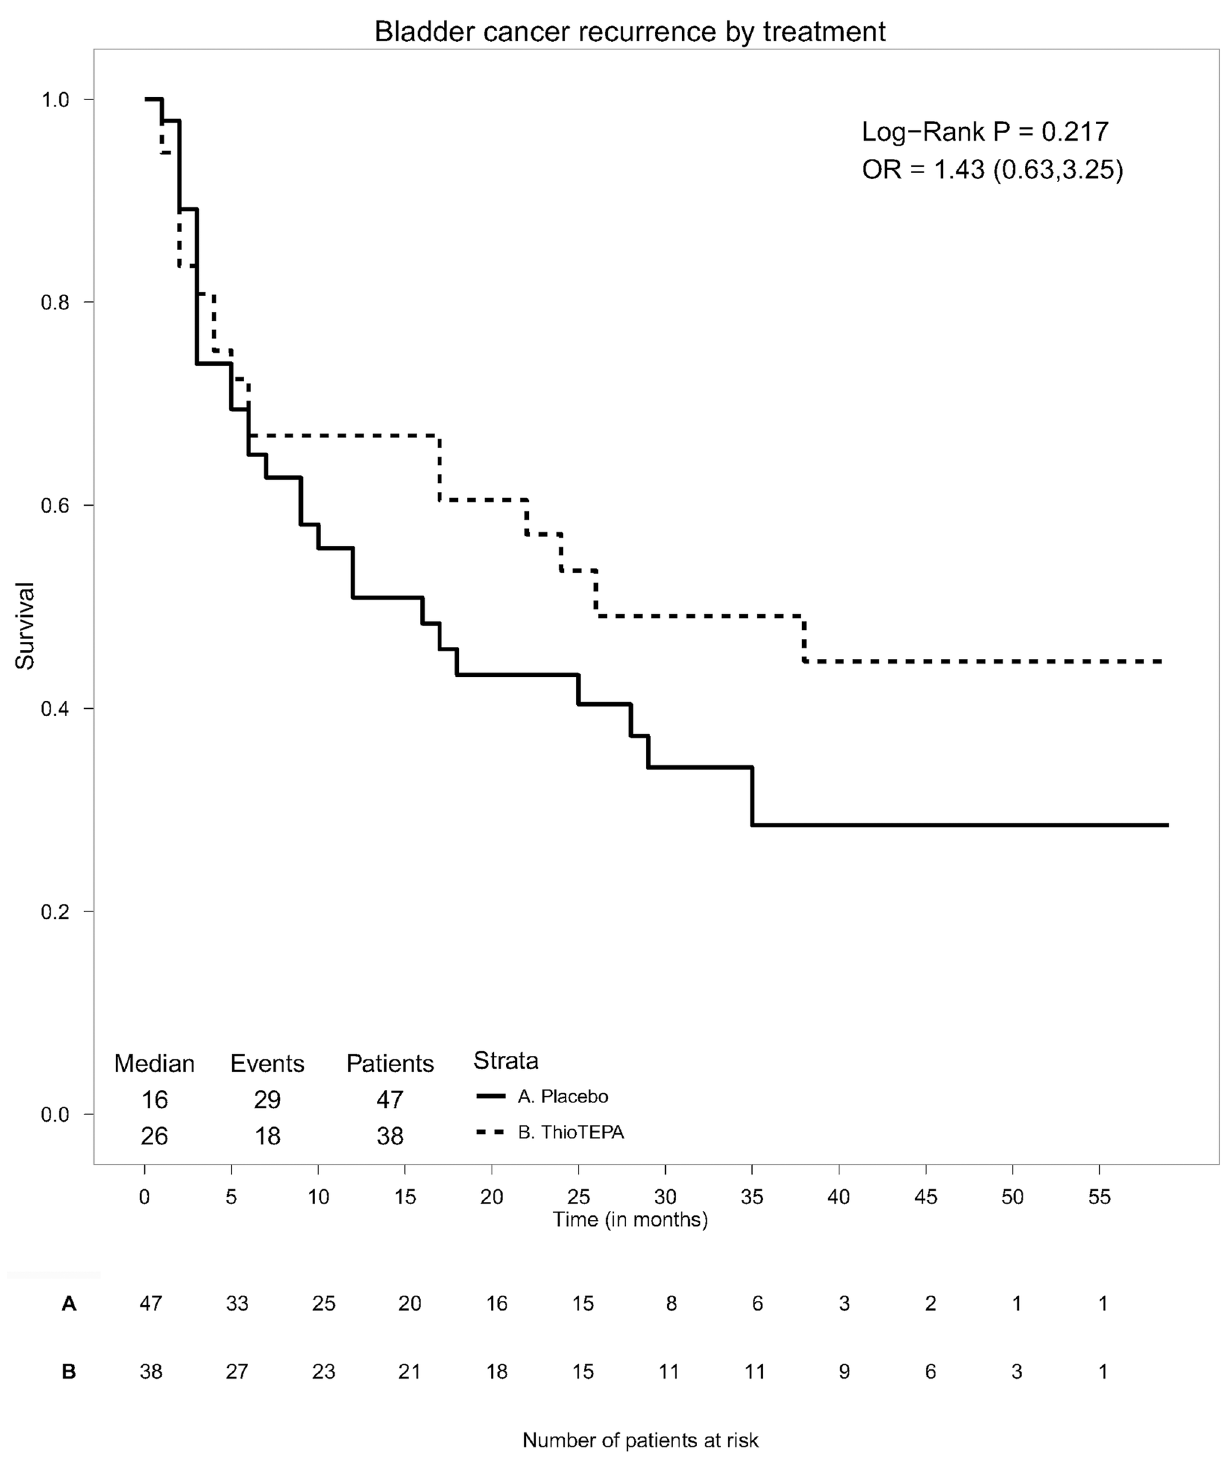
Fig 3. Comparison of the survival curves of two groups of patients. The plot is followed by the number of patients at risk for each group.